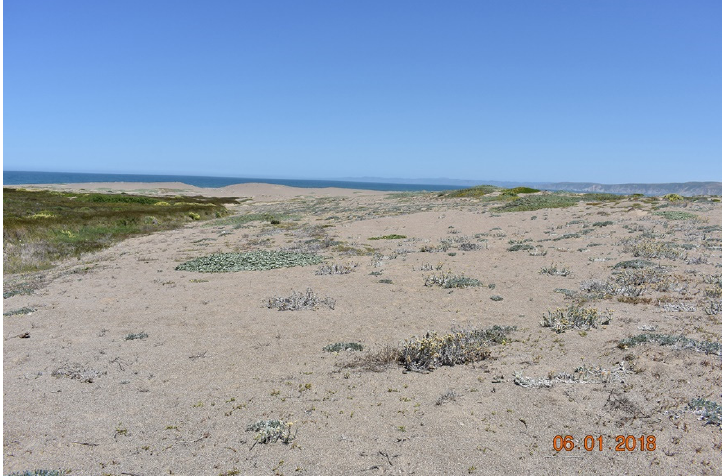
Figure 4. Low cover area at Point Reyes restored using heavy equipment.